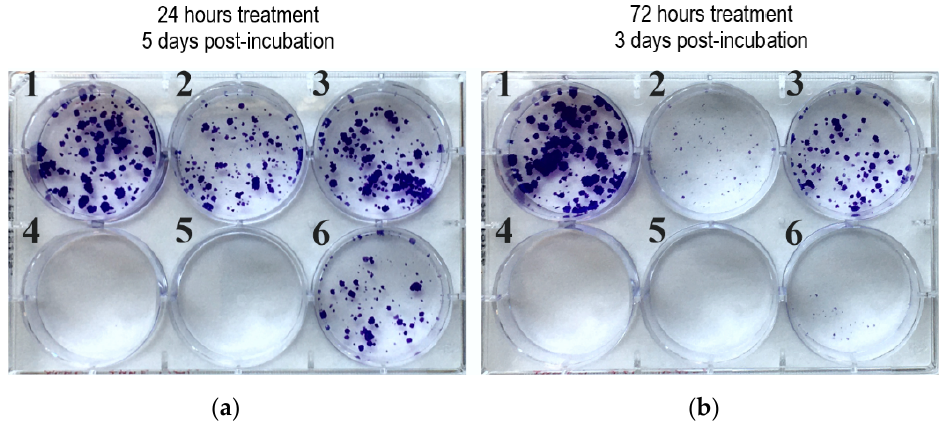
Figure 3. Colony formation assay of selected imipridone hybrids on PANC-1 cell line at 10µM con- centration: ( a ) 24 h treatment followed by 5 days postincubation; ( b ) 72 h treatment followed by 3 days postincubation. 1: control; 2: 10a ; 3: 17b ; 4: 17c ; 5: 17d ; 6: ONC201.